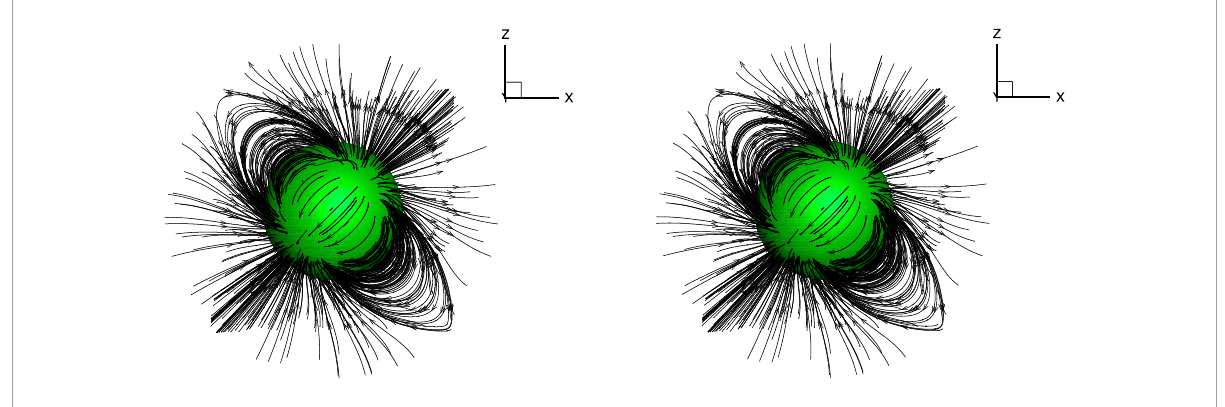
FIGURE 3 Depiction of the gradient ∇Φ of Φ in the test problem with the analytic solution: (left) analytic solution and (right) numerical solution.